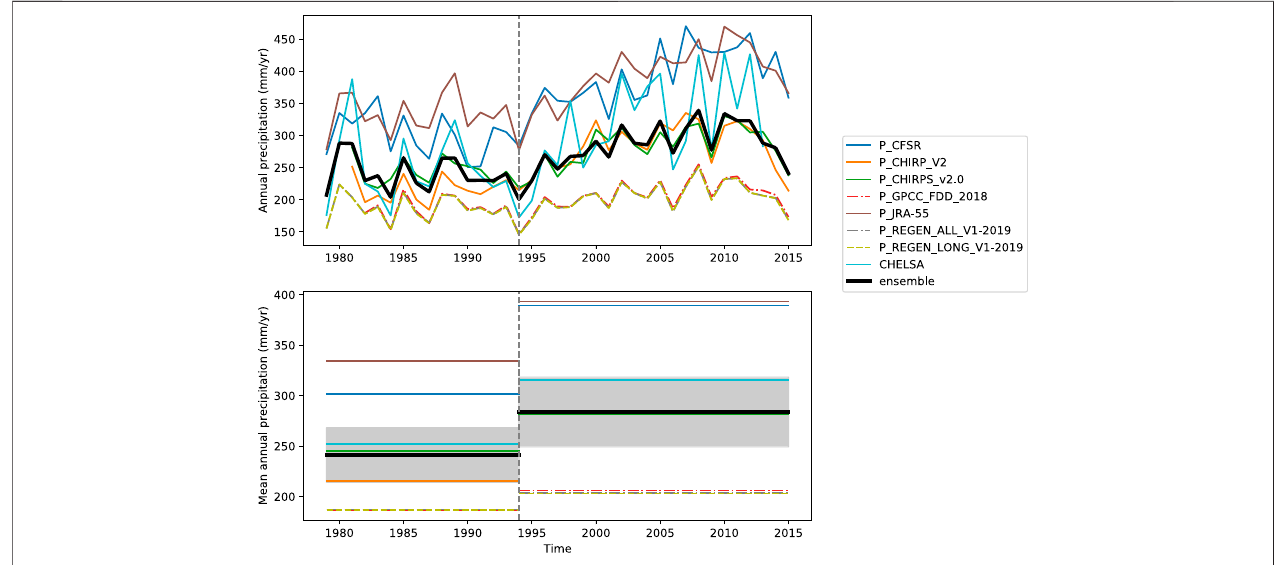
FIGURE 8 | Annual precipitation (upper panel) and mean annual precipitation (lower panel) for the eight members of the FROGS ensemble and for the whole study area. The shaded area in the lower panel shows ± one standard deviation of the annual series of P ensemble for the period considered.